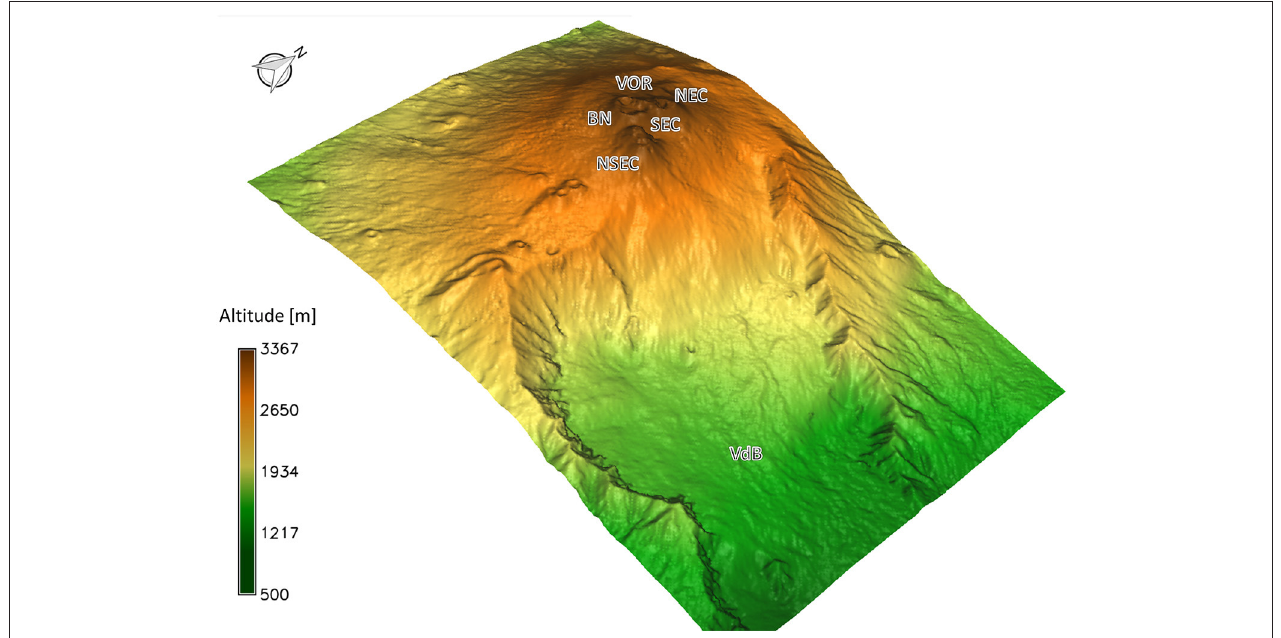
FIGURE 3 | Digital Elevation Model (DEM) of Mount Etna, covering the summit craters and a small portion of the south-east flank of the volcano, obtained by processing tri-stereo Pléiades images acquired on December 18, 2015. NEC, North-East Crater; VOR, Voragine; BN, Bocca Nuova; SEC, South-East Crater; NSEC, New South-East Crater; VdB; Valle del